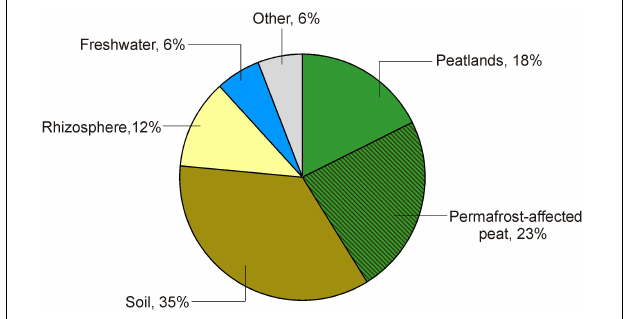
FIGURE 5 | Distribution of Acidisarcina species in the environment. The diagram depicts origin of environmental 16S rRNA gene sequences with > 95% identity to Acidisarcina polymorpha SBC82 T , which were extracted from the Joint Genome Institute Integrated Microbial Genomes database (16S rRNA Public Assembled Metagenomes). More detailed information about these sequences is given in Supplementary Table S3